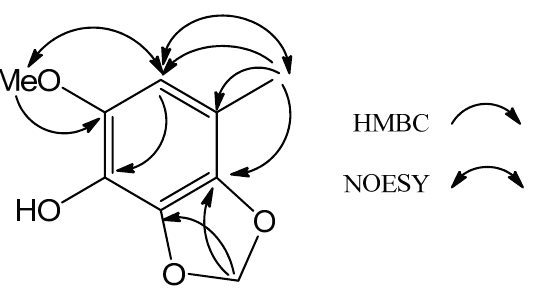
Figure 2. Key HMBC and NOESY of 1